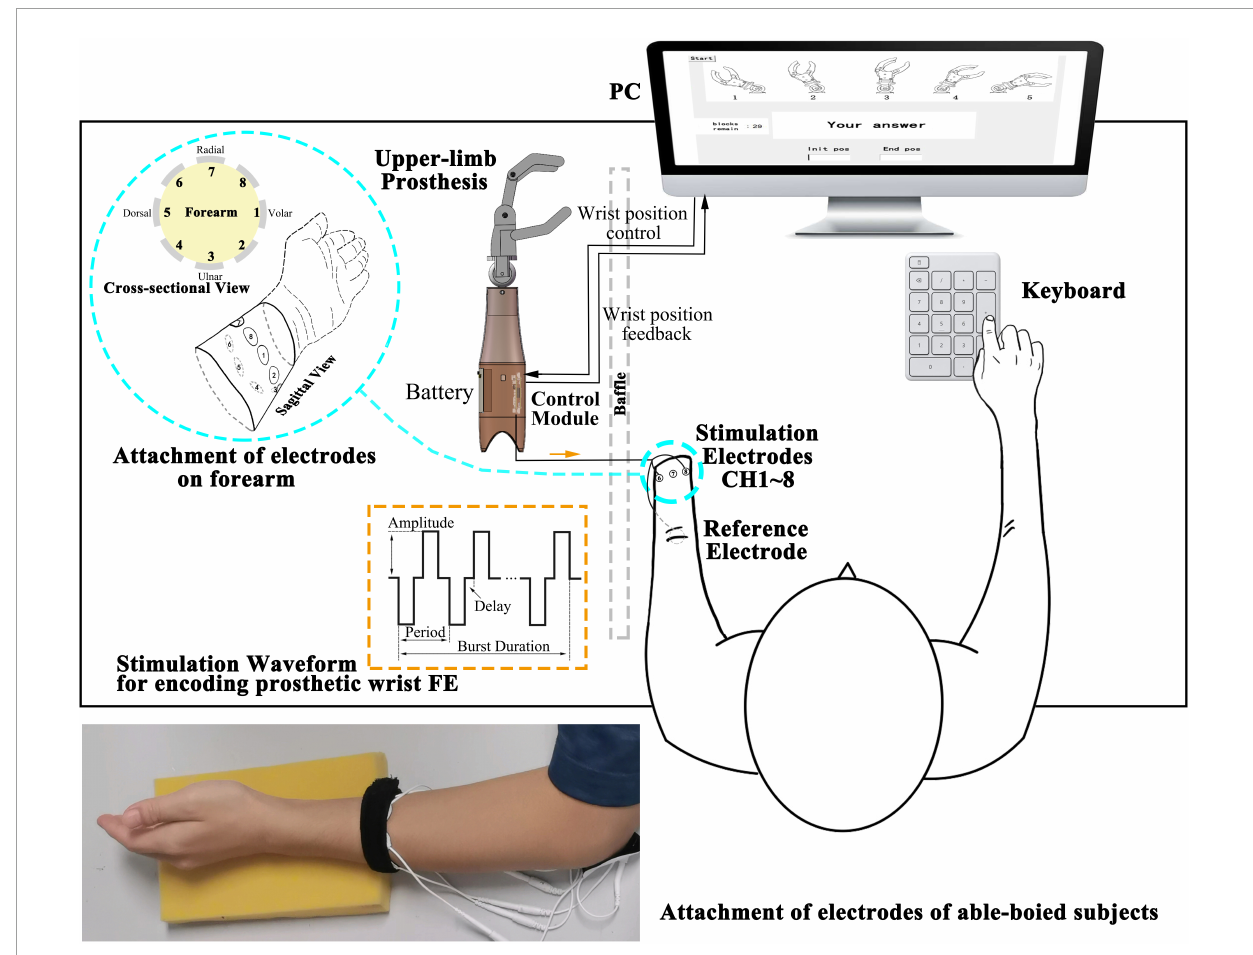
FIGURE1 Illustration of the modules comprising the experimental platform. The control module and battery are embedded in the shell of the upper-limb prosthesis. The control module receives the wrist position control signal from the PC to drive the prosthesis and provided feedback on the wrist position to the PC. The square biphasic current stimulation waveforms in orange dashed line rectangle (amplitude, period, delay, and burst duration as adjustable parameters) are generated and conveyed to the subjects through electrodes. A cross-sectional and sagittal view of eight stimulation electrodes distribution around the forearm are shown in the enlarged blue circle. CH1 (Channel 1) is on the volar side, and eight channels are equally attached and arranged along the pronation direction. Subjects perceive the stimulation and input the answer by a keyboard. The photograph at the bottom shows the attachment of electrodes of an able-bodied